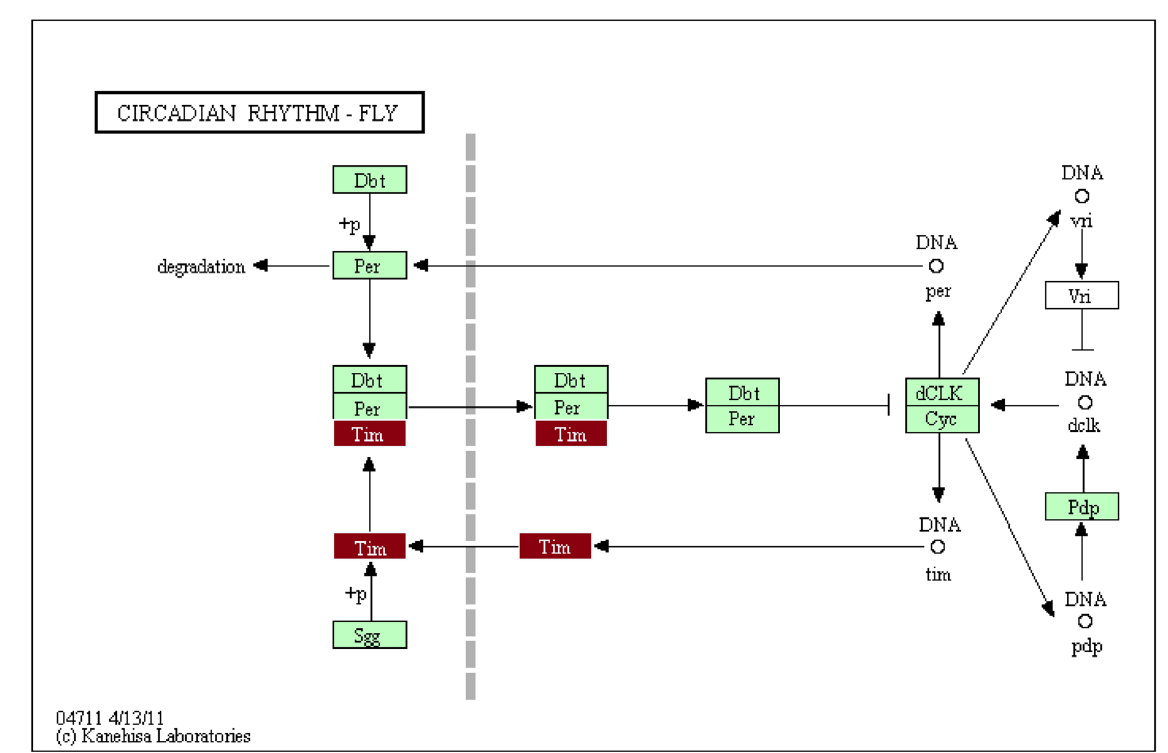
Figure 3. The circadian rhythm pathway in Daphnia pulex showing gene of interest (Tim) in red and other identified genes in green.